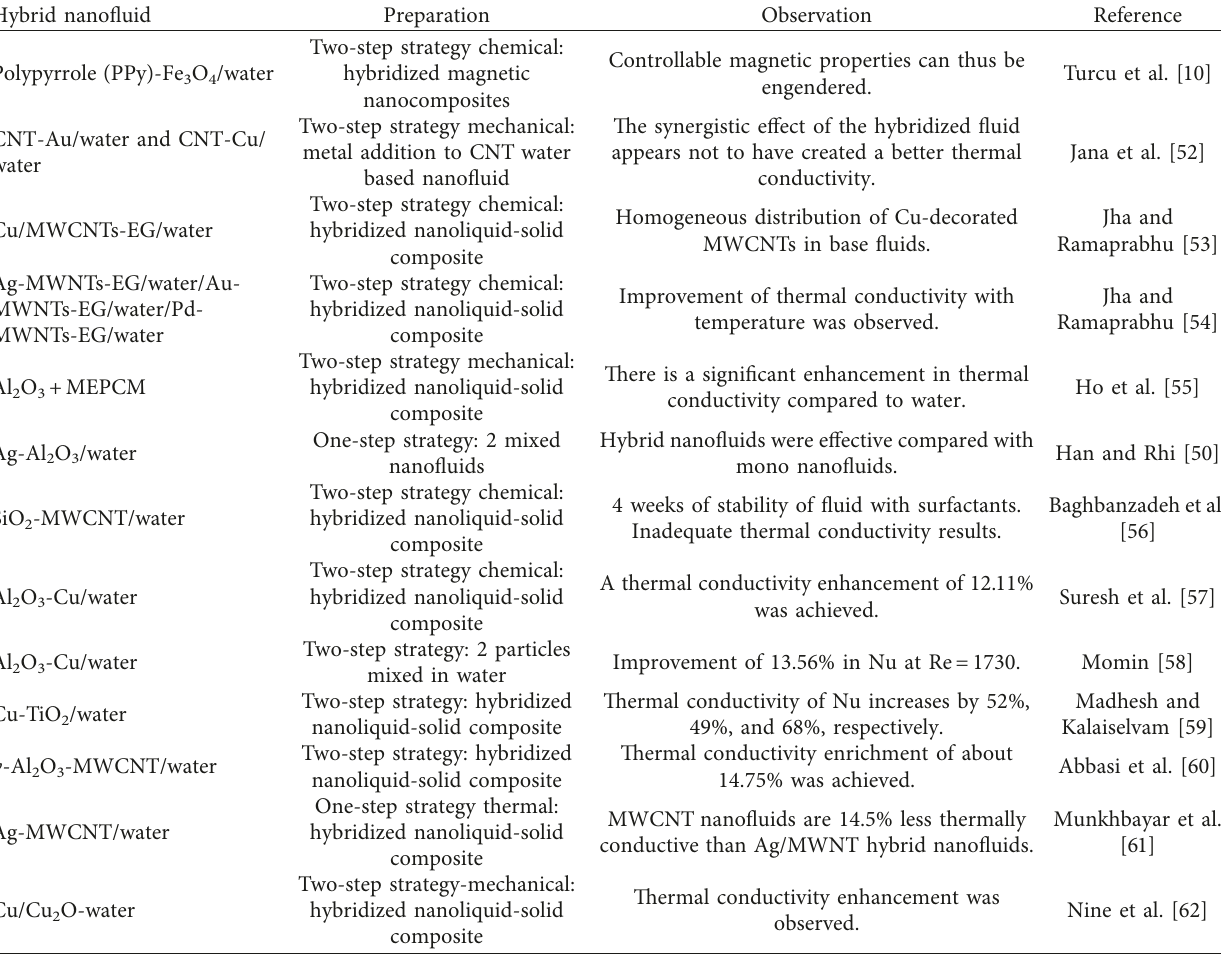
Figure 9: Two-step preparation process of nanofluids (direct mixing of nanoparticles followed by addition of dispersant and ultrasonication). Table 1: Some syntheses of hybrid nanofluids conducted by different